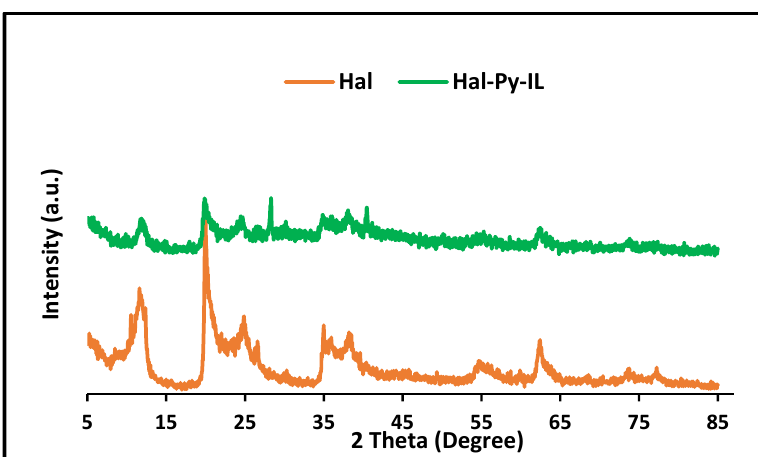
Figure 5 . XRD patterns of Hal and Hal-Py-IL. Figure 5. XRD patterns of Hal and